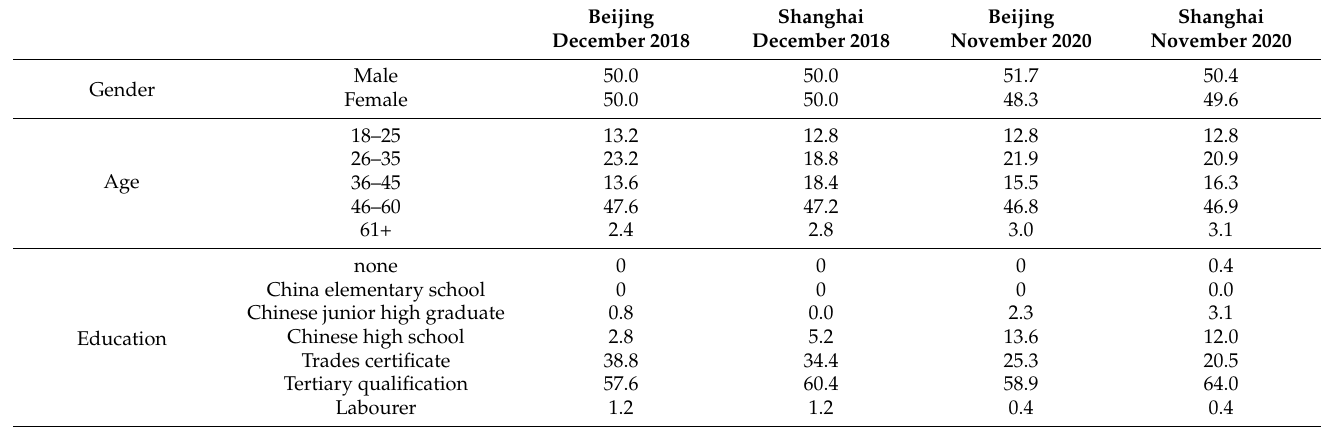
Table 1. Demographic characteristics of consumers